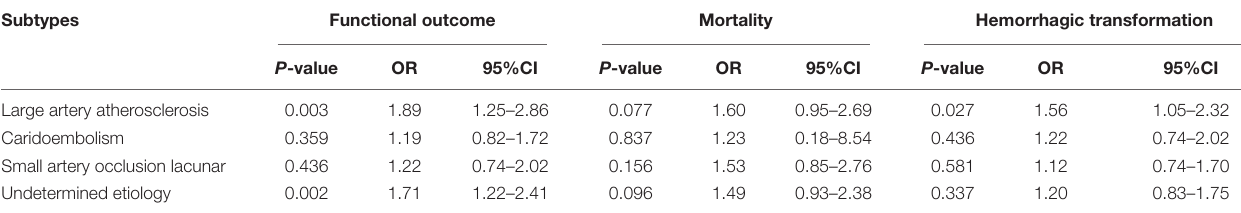
TABLE 4 | Association between NT-proBNP and stroke outcome in subtypes of